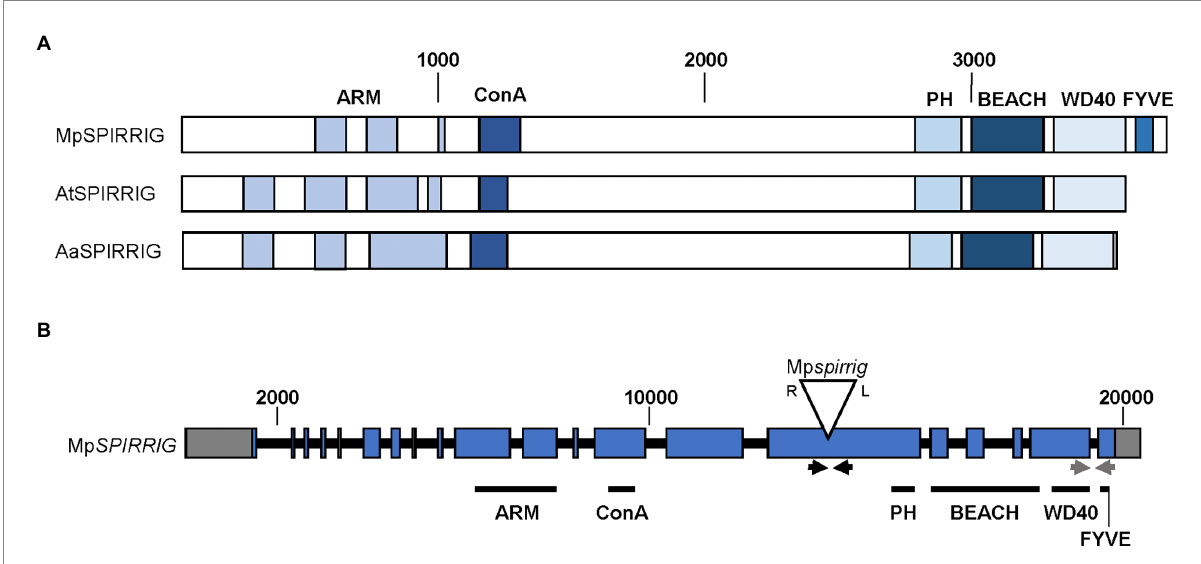
FIGURE 1 Gene and protein structure of Mp SPIRRIG . (A) Comparison of the Mp SPIRRIG , AtSPIRRIG, and AaSPIRRIG protein structures. Sizes are indicated by amino acid (aa) numbers. The three homologs are similar in length: MpSPI (3,766 aa), AtSPI (3,601 aa), AaSPI (3,570 aa). ARM = Armadillo repeats, ConA = Concanavalin A-like lectin domain, PH = pleckstrin homology domain, BEACH = BEige and Chediak-Higashi domain, WD40 = WD40 repeats, FYVE = FYVE domain. (B) Gene structure of Mp SPI including the T-DNA insertion site in Mp spi . Mp SPI has 20 exons (indicated in blue). The T-DNA insertion is indicated by the triangle, R and L mark the T-DNA borders. Gray boxes show UTRs and black lines depict introns. The arrows indicate primer pairs used for RT-PCR (black) and qPCR